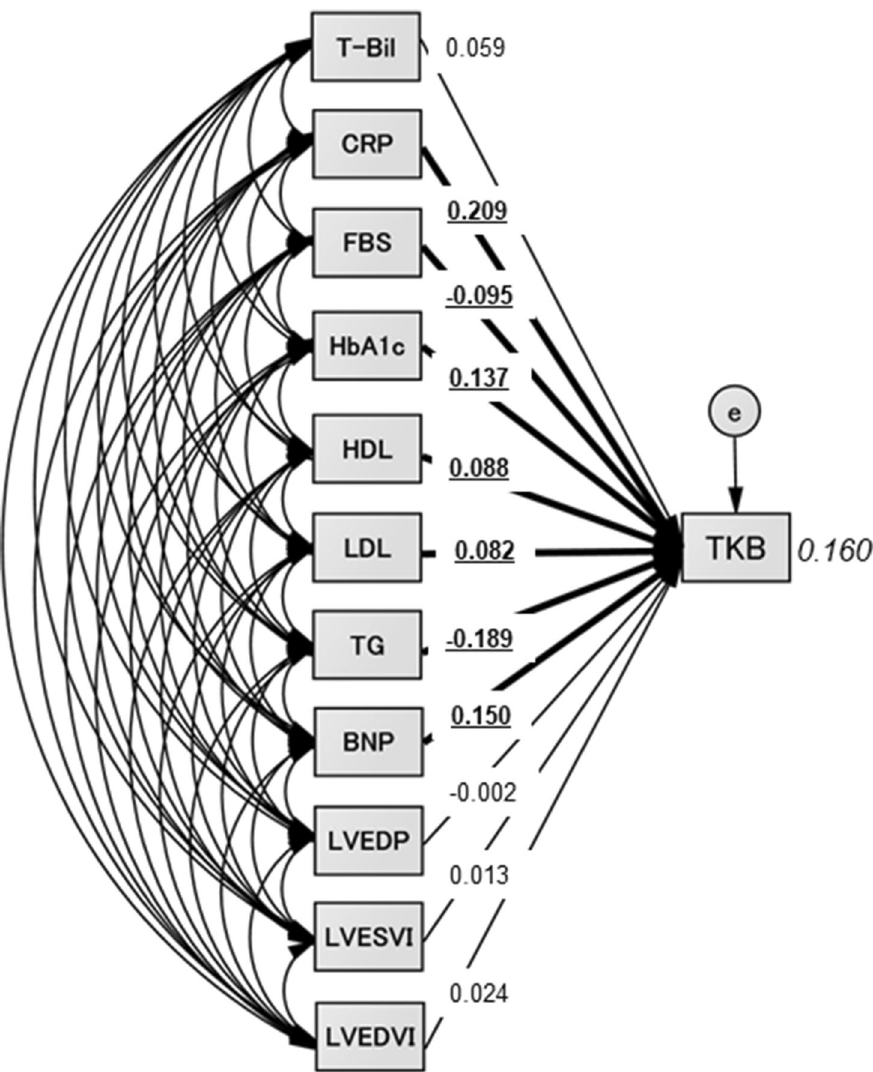
coefficient representing the standardized coefficient of a regressing independent variable on a dependent variable of the relevant path. These variables represent the standardized regression coefficient (direct effect) (underlined portions indicate remarkable values) and squared multiple correlation (in narrow italics). T-Bil total-bilirubin, CRP C-reactive protein, FBS fasting blood sugar, HDL high-density lipoprotein cholesterol, LDL low-density lipoprotein cholesterol, TG triglyceride, BNP B-type natriuretic peptide, LVEDP left ventricular end-diastolic pressure, LVESVI left ventricular end-systolic volume index, LVEDVI left ventricular end-diastolic volume